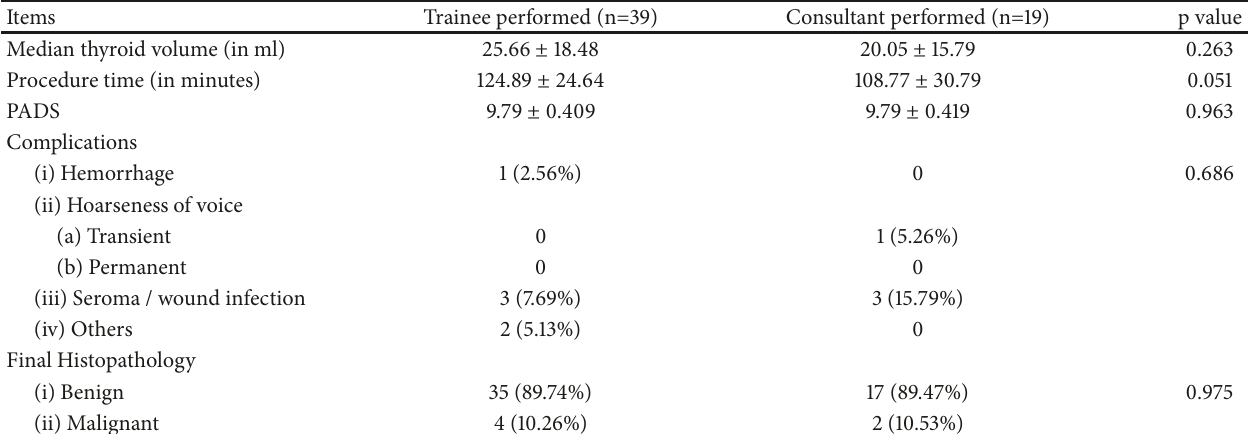
Table 4: Trainee versus consultant performed short stay